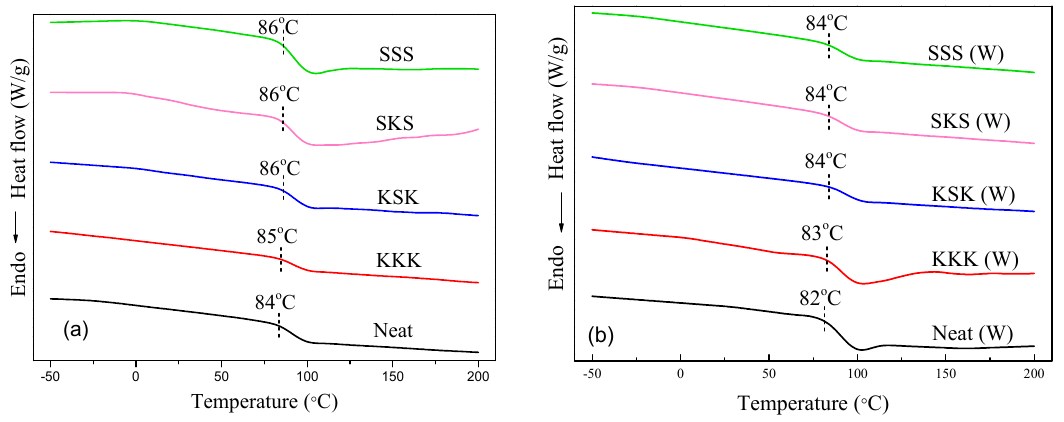
Figure 6. DSC thermograms of ( a ) before and ( b ) after weathering composite samples.